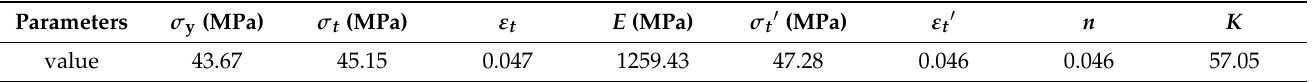
Table 1. PVC material tensile testing result.